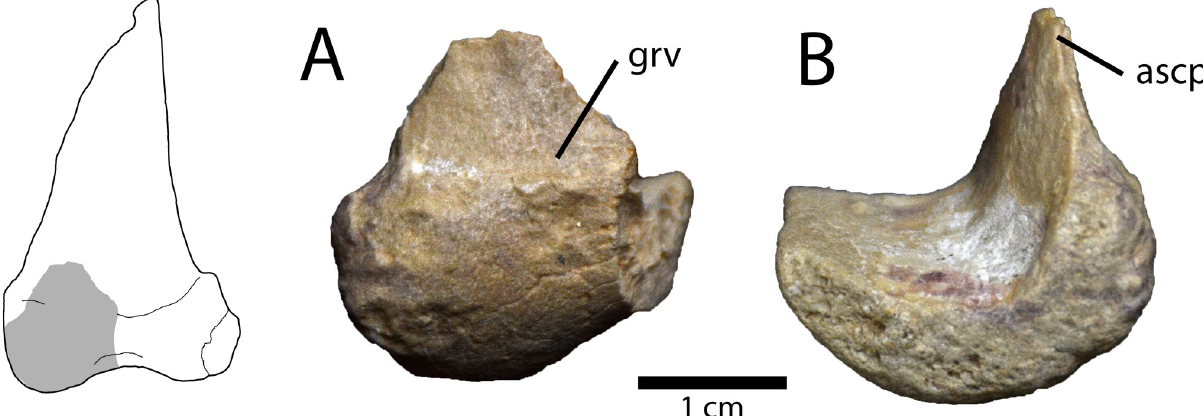
Fig 5. Partial astragalus of Elmisaurus rarus (MPC-D 102/113). A, B, Partial left astragalus in anterior (A) and medial (B) views. Interpretive illustration of “ Nomingia gobiensis ” (MPC-D 100/119) shows the preserved portion in MPC-D 102/113. Abbreviations: ascp , ascending process; grv , transverse